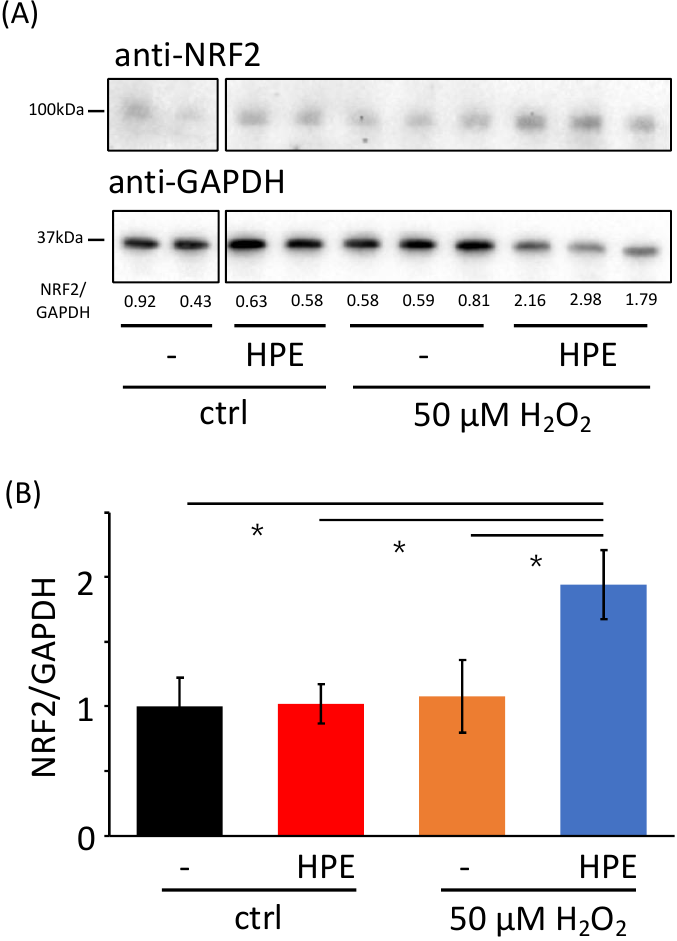
Figure 4. Increased NRF2 protein levels in H 2 O 2 -treated NHDFs with HPE. ( A ) NRF2 (upper panel) and GAPDH (bottom panel) protein levels, under indicated conditions, were detected. Numbers are relative NRF2 intensities, normalized by GAPDH, quantified using Image Lab software. ( B ) The bar graph shows a relative densitometry representation of ( A ). Sample numbers were 7 in each condition. Paired t -test; * p < 0.05 by Student’s two-tailed t -test.